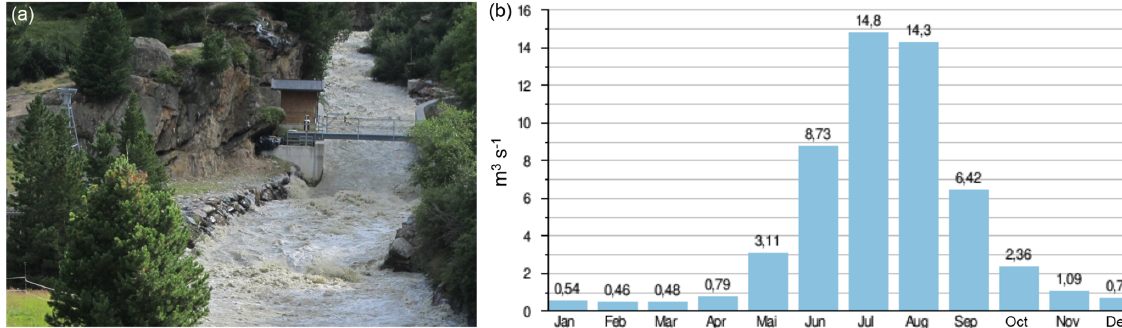
Figure 14. The rainfall totalisator and the gauge at Vent (1891ma.s.l., 46.85722 ◦ N, 10.91083 ◦ E) ( a ; Photo: Hydrographic Service of the Tyrol), and mean monthly streamflow of the Rofenache 1971–2009 (b) . Data from the Hydrographisches Jahrbuch (BMLFUW